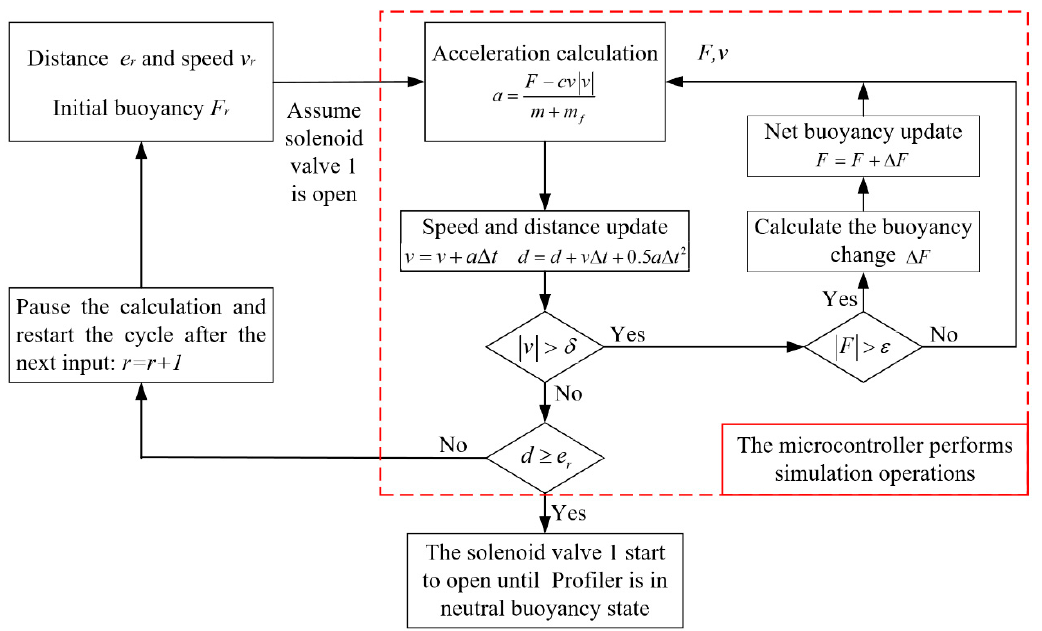
Figure 2. Flow chart of the depth control algorithm driven by ocean thermal energy.